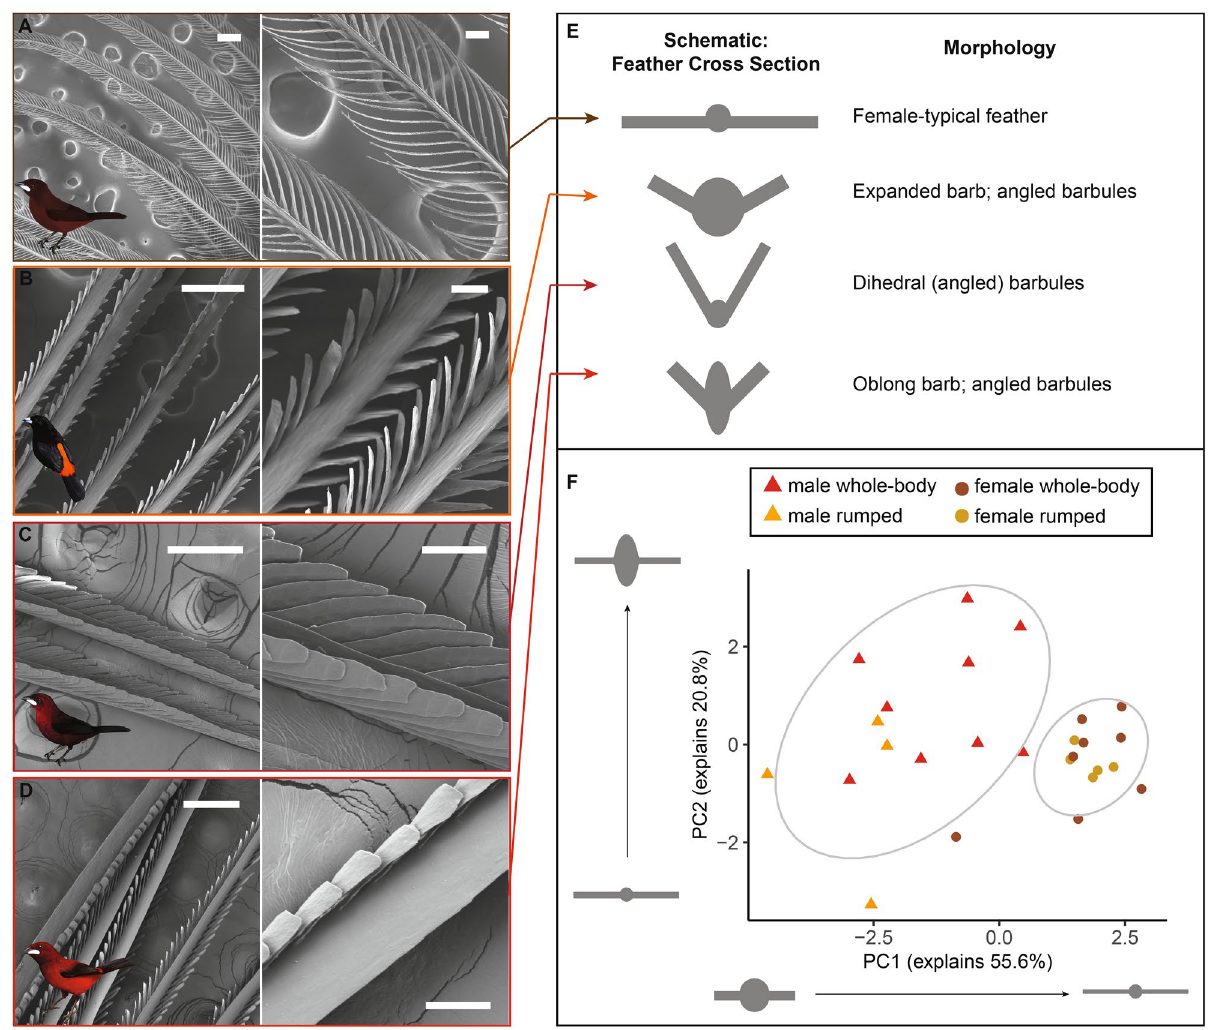
Figure 4. Males, but not females, have diverse and elaborate feather microstructure. ( A ) Female R. carbo red chest feather with typical simple morphology. ( B ) Male R. passerinii bright orange rump feather with expanded barb and strap-shaped barbules. ( C ) Male R. carbo velvet red back feather with dihedral barbules. ( D ) Male R. dimidiatus shiny red rump feather with expanded, oblong barb and strap-shaped barbules. Scale bars in left column are 200 µm; scale bars in right column ( B , D , F , H ) are 50 µm. Artwork in inset silhouettes credit Gabriel Ugueto; female silhouette in A is modified by Allison Shultz from original art by Gabriel Ugueto. E. Schematic illustrations of idealized cross-sections of each feather type in A - D . ( F ) PCA of log-transformed centered microstructural measurements for all patches from all males and all females, showing that males separate from females. Male and female microstructures are not correlated (PGLS with microstructure PC1 scores: coefficient = -0.023, SE = 0.17, p = 0.90). This PCA does not consider differences in three-dimensional structure, including dihedral barbule morphology; see Table Some plumages incorporate melanin, particularly in females. In some cases, male and female birds differed perceptibly in not only saturation but also brightness and hue, which (unlike most changes in saturation) could be explained by melanin 76 . We found indirect evidence of melanin in regions from 8 females and 2 males (Fig. S5A; by analyzing reflectance curves) and direct microscopy evidence of melanin in five of six colorful females and one of six colorful males (Fig. S5B-G). Taken together, these exploratory results suggest that melanin pigments play a role in any unexplained differences in brightness or hue between male and female feathers. Males, but not females, have diverse and elaborate feather microstructure. Female Rampho- celus tanager feathers were mostly of standard microstructural appearance 29 . That is, feather microstructure usually looks the same as feather macrostructure, with simple cylindrical barbules extending from the central cylindrical barb, all in a single plane (Fig. 4A, Table 1, Table S3). The only female to exhibit broad variation was